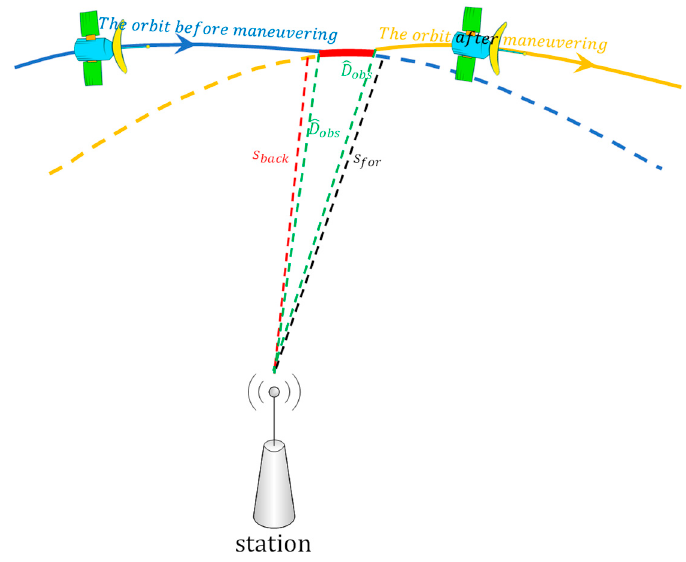
Figure 2. Schematic scheme of orbital maneuver detection.